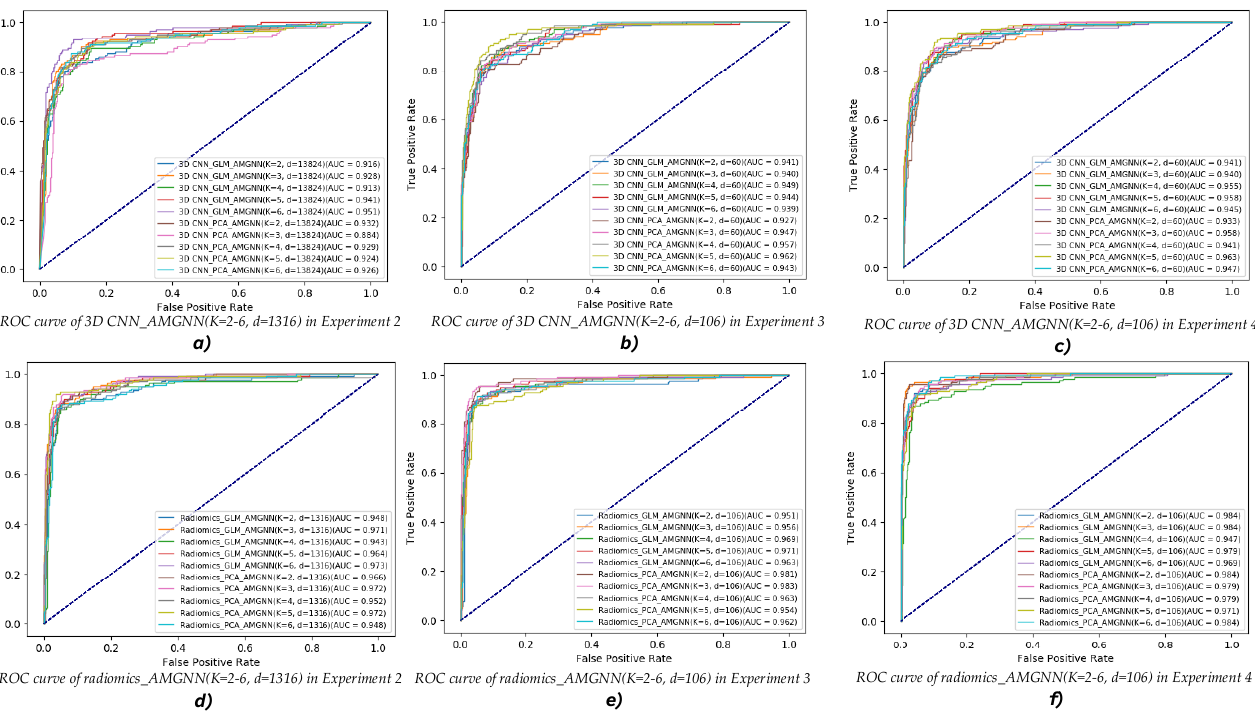
Figure 7. ROC curves of the AMGNN classifier in Experiments 2-4. ( a – f ) ROC curves of the AMGNN classifiers with different combination vectors.